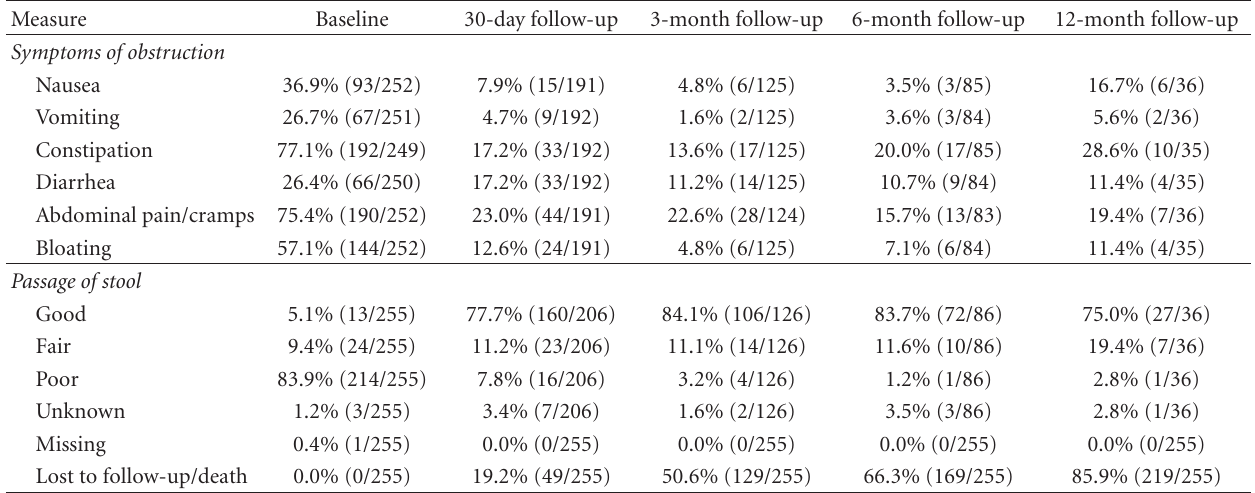
Table 1: Patient